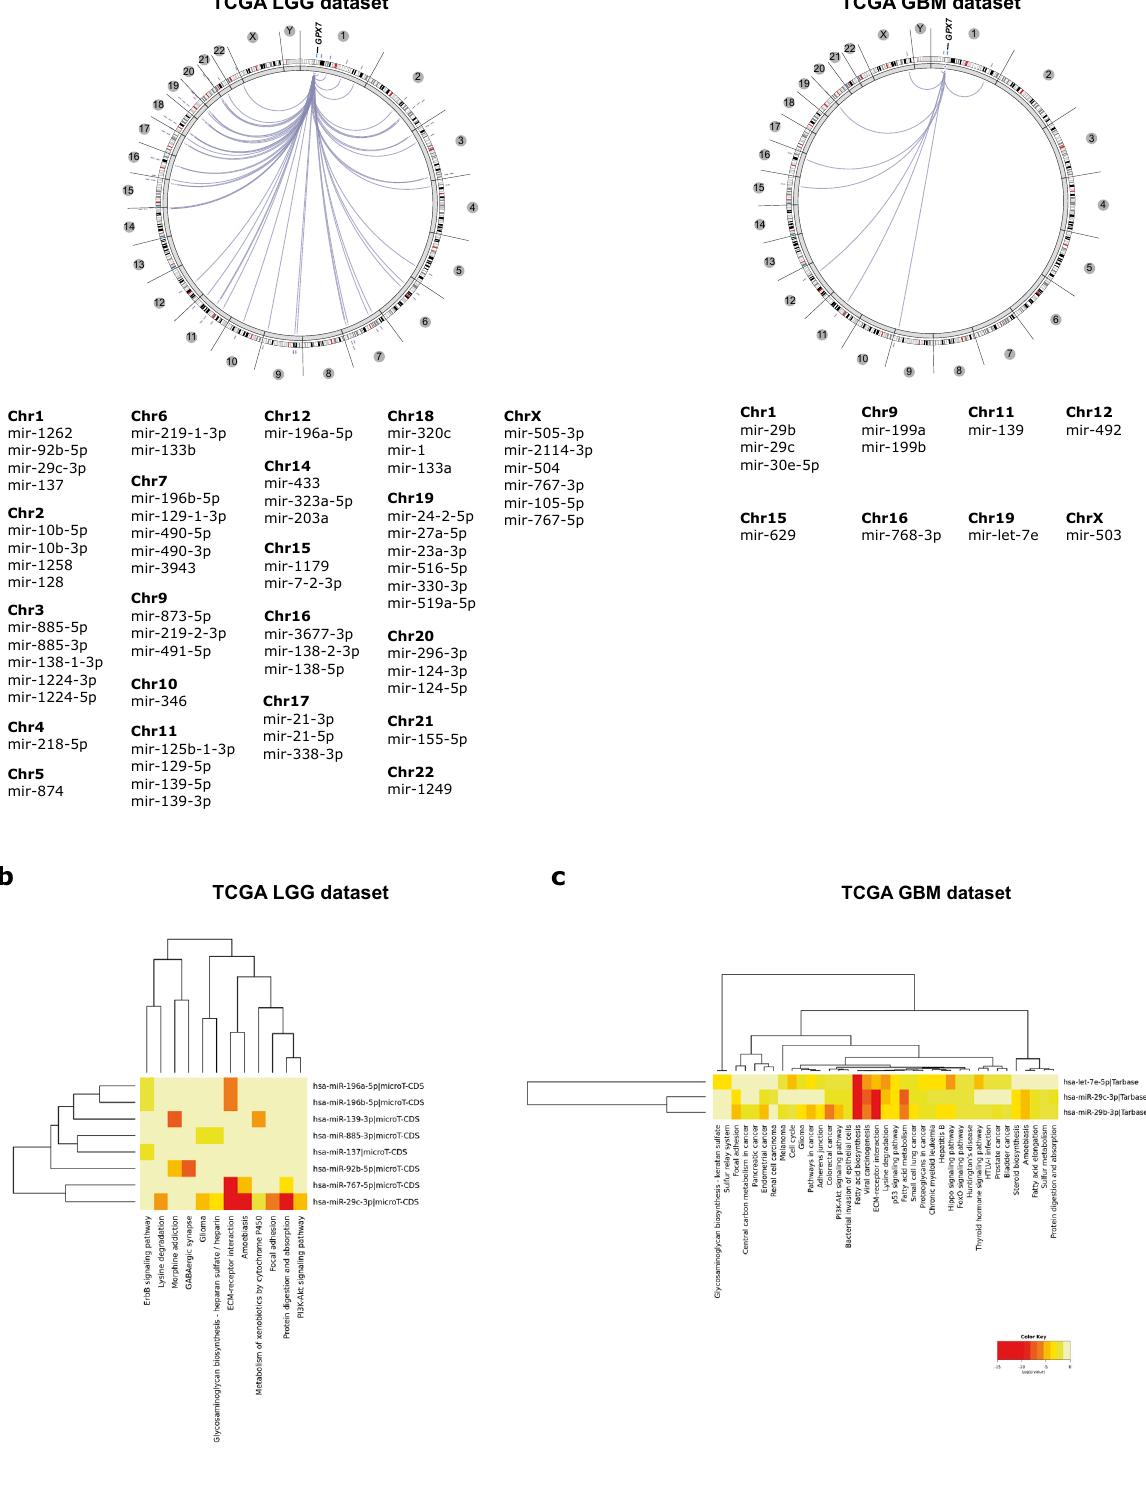
Figure 7. Genome-wide associations among GPX7 and miRNAs in the LGG and GBM. ( a ) Circos plots of predicted miRNAs signatures co-expressed with GPX7 in LGG and GBM patients from the TCGA database. Only genes with a correlation of Abs = 0.4 and p < 0.05 are shown in the circus plots. Chromosomes 1–Y are shown outer in the right half of the circle. miRNA genes are represented by purple lines near their chromosomal locations. The outer ring displays cytogenetic bands. In this case, lines connecting two dots represent the statistically significant correlation between two selected features: miRNA expression and GPX7 expression. Heat-maps of significant KEGG pathways of GPX7 - associated miRNAs by utilizing the DIANA-miRPath in ( b ) TCGA-LGG and ( c ) TCGA-GBM. Each row represents a miRNA, and each column represents the KEGG pathway 51,58–60 . Gradient from red to yellow indicates a higher to lower p -value